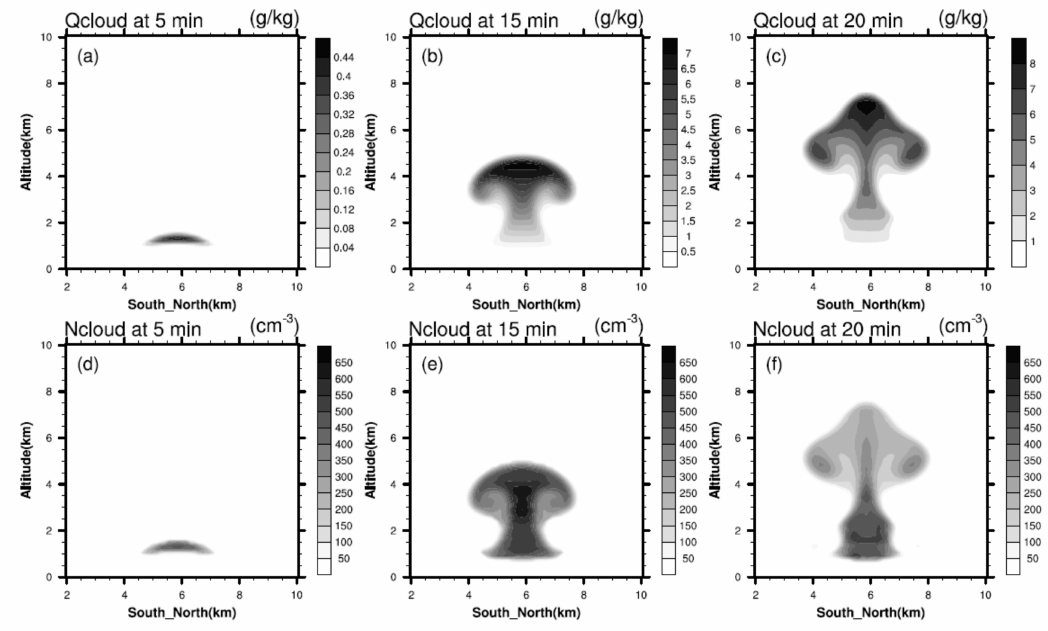
Figure 7. Cloud water mixing ratio and cloud number concentration in the 3D radiation case at 5 min ( a , d ), 15 min ( b , e ), 20 min ( c , f ).